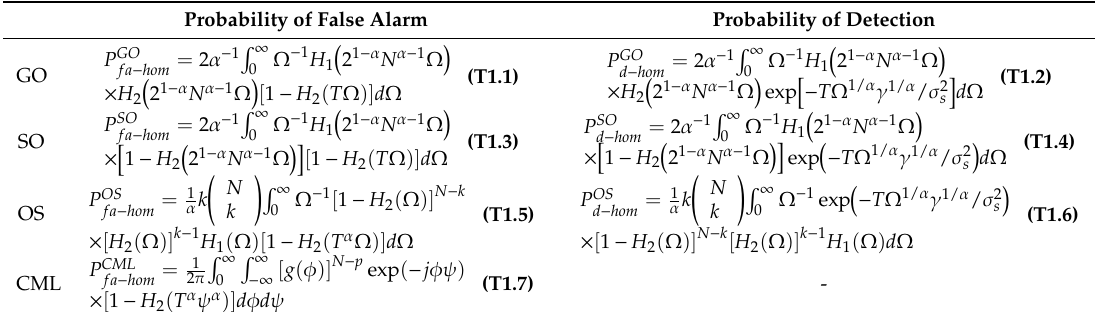
Table 1. The probabilities of a false alarm (Pfas) and probabilities of detection (Pds) of di ff erent detectors in a homogeneous positive alpha-stable (P α S)